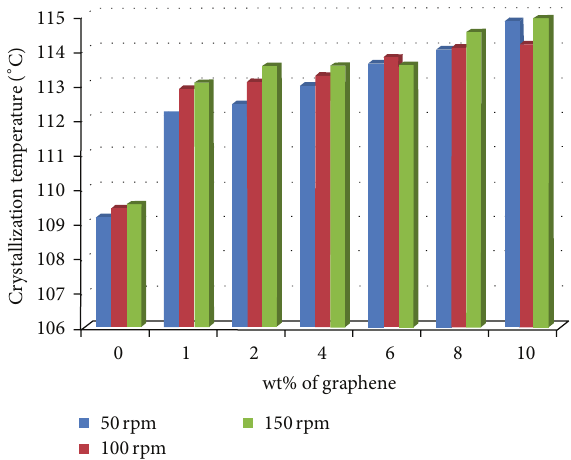
Figure 6: Effect of graphene addition on crystallization temperature of LLDPE/C-GNPs composites at different extruder